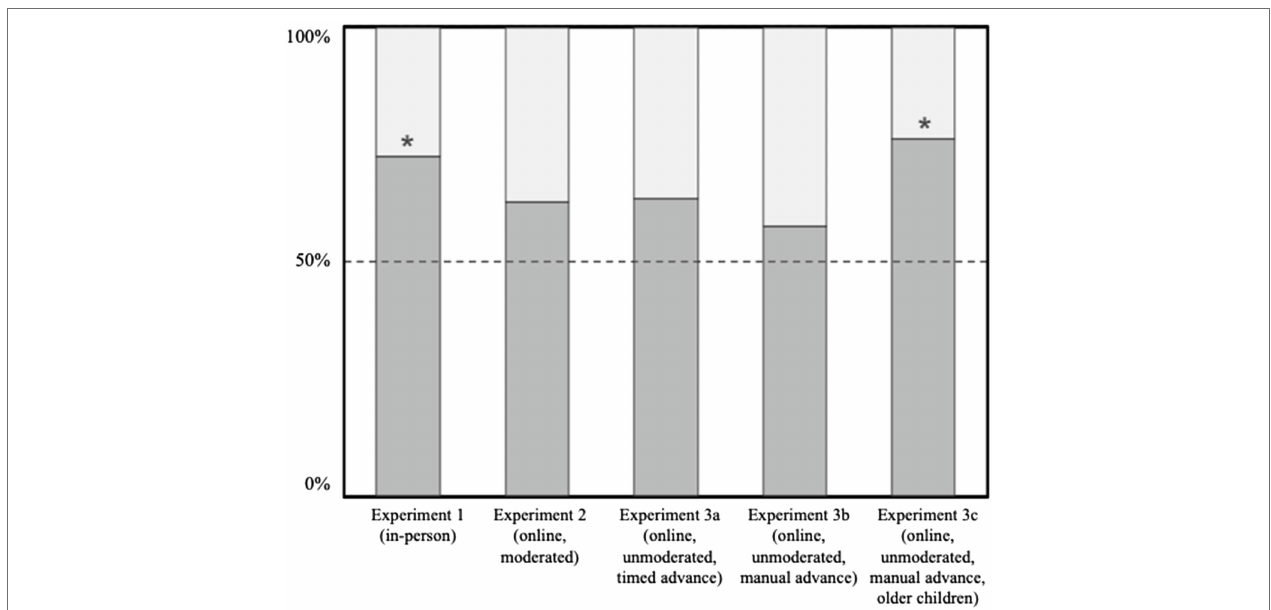
FIGURE 3 | The proportion of children’s choices across in-person (Experiment 1), online-moderated (Experiment 2) and online-unmoderated (Experiments 3a-3c) testing platforms. Asterisks denote significance at p <